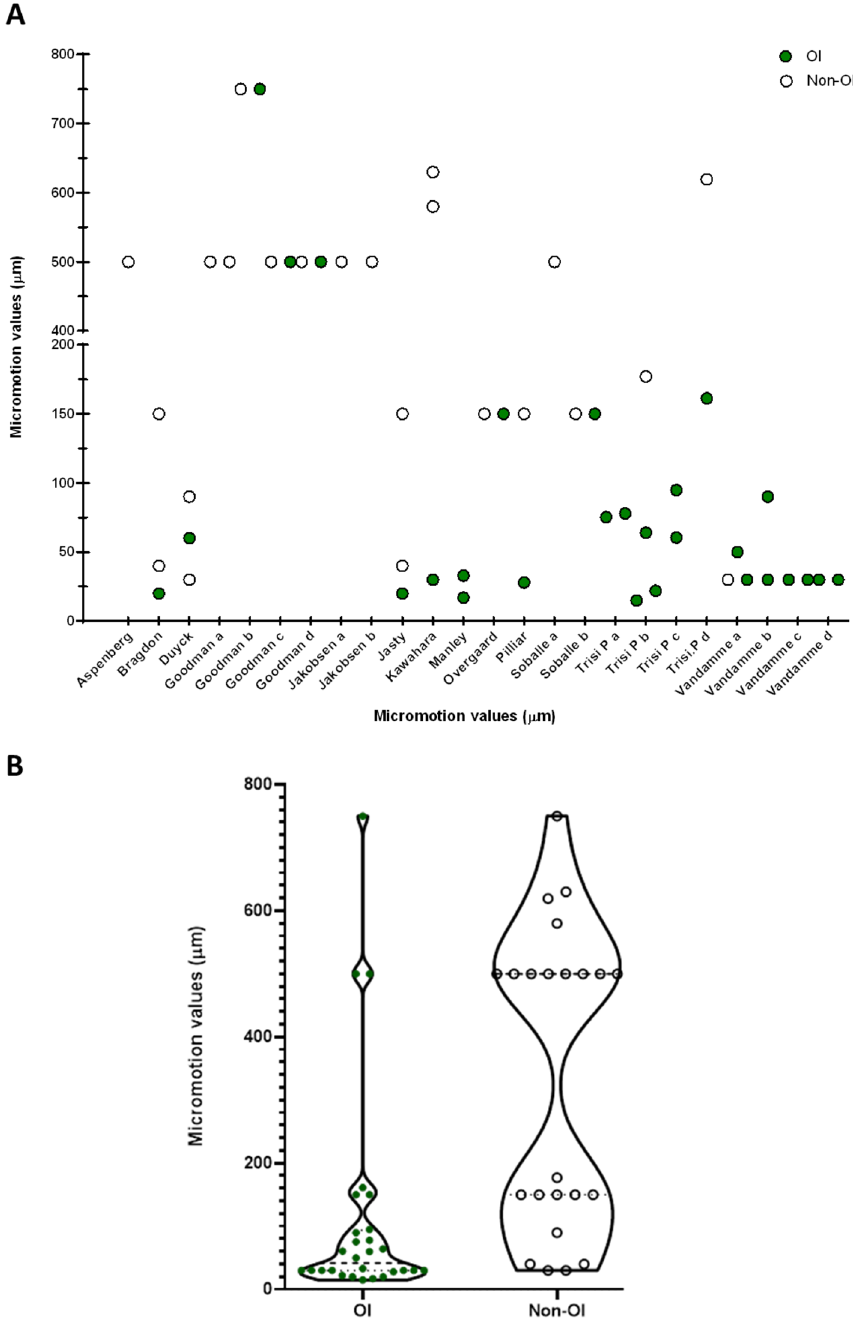
Figure 2. ( A ) Scatterplot of the animal data showing the micromotion value for osseointegrated (green, circle, n = 28) and non-osseointegrated (hollow circles, n = 23) samples. ( B ) Violin plot of the same data. Whilst micromotion was lower for the osseointegrated samples (Mann Whitney test p < 0.001), there was also considerable overlap between the